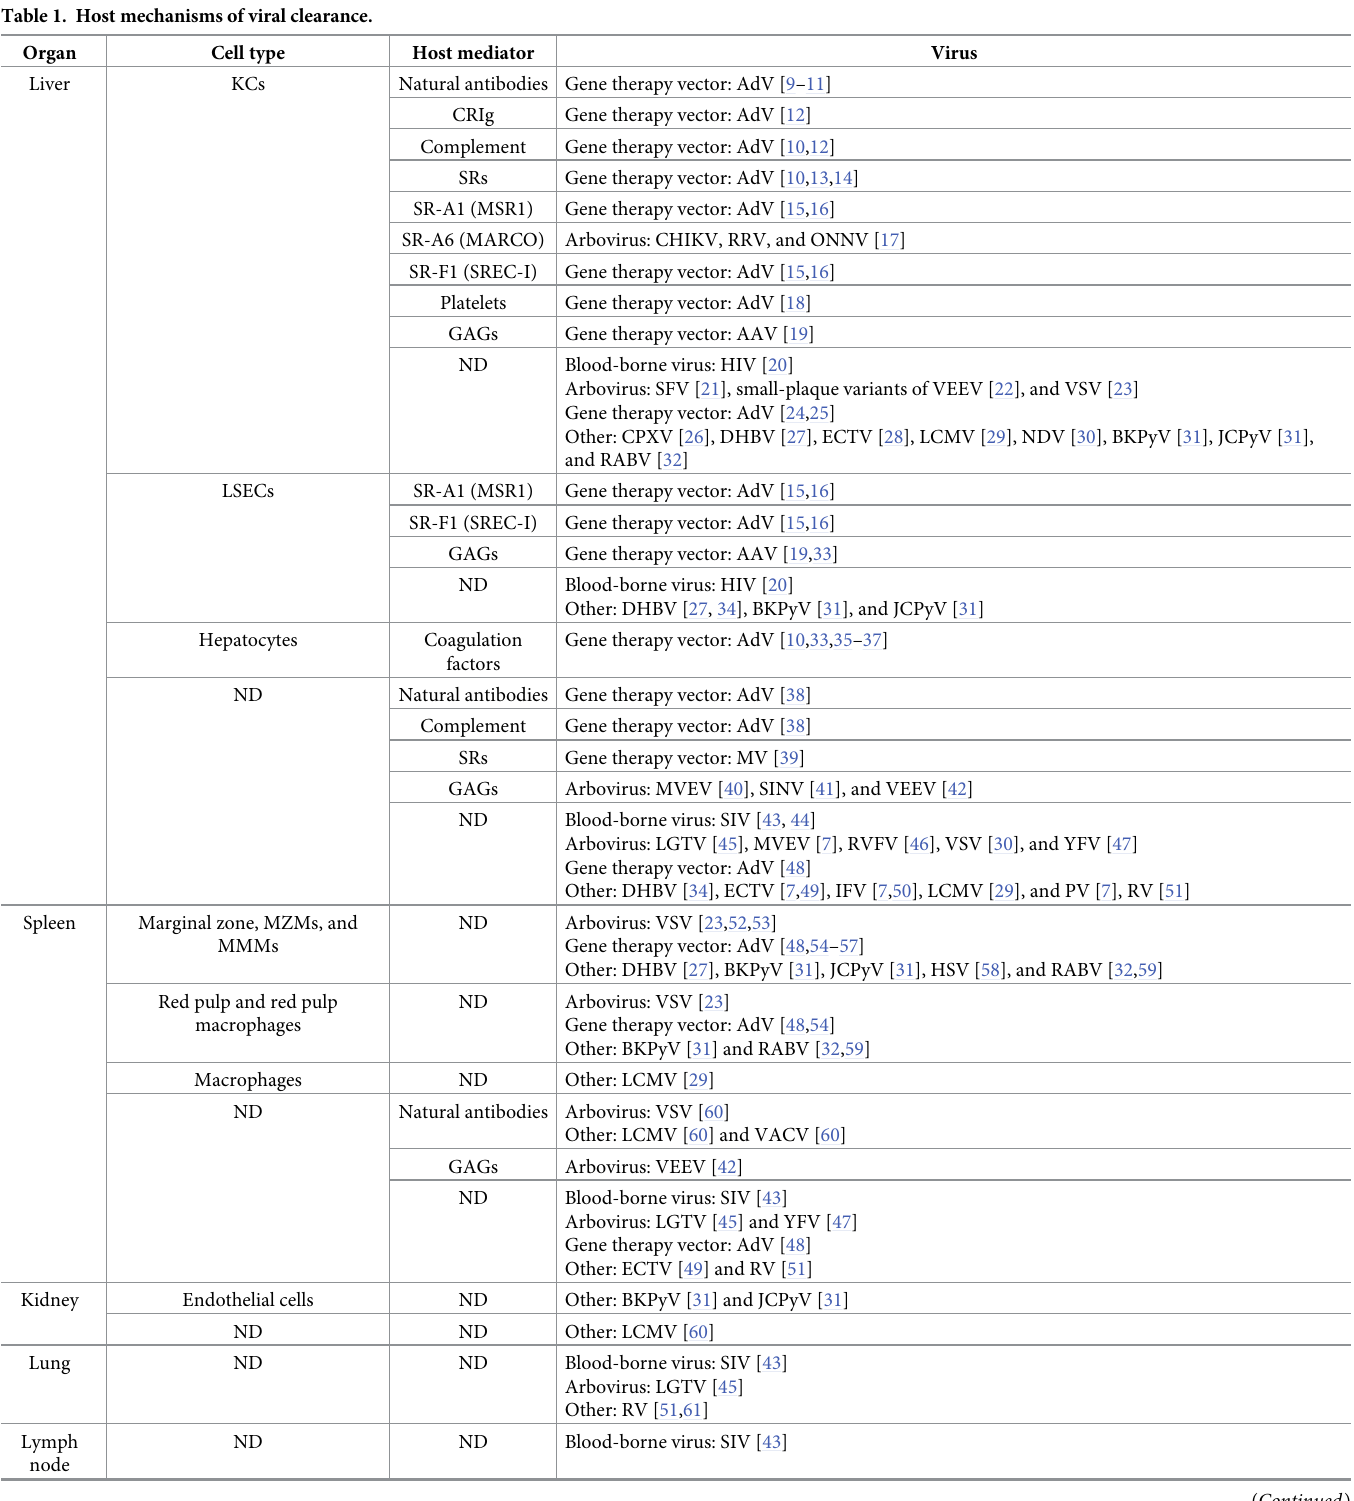
Table 1. Host mechanisms of viral